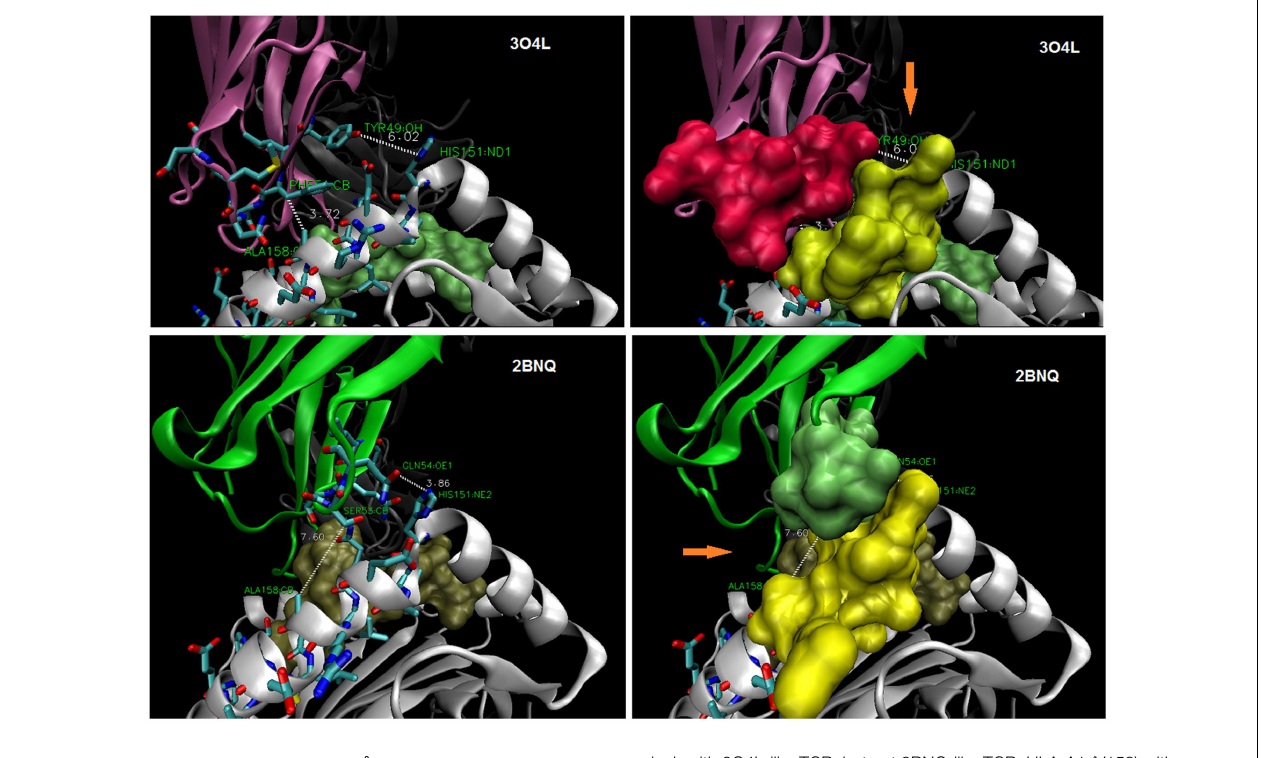
dock with 3O4L-like TCR, but not 2BNQ-like TCR; HLA-A1 (V158) with 2BNQ-like, but not 3O4L-like TCR. CDR2 α and α 2-helix (a.a. 151–158) side chains as stick (left), and space-filled (right); peptides are shown as